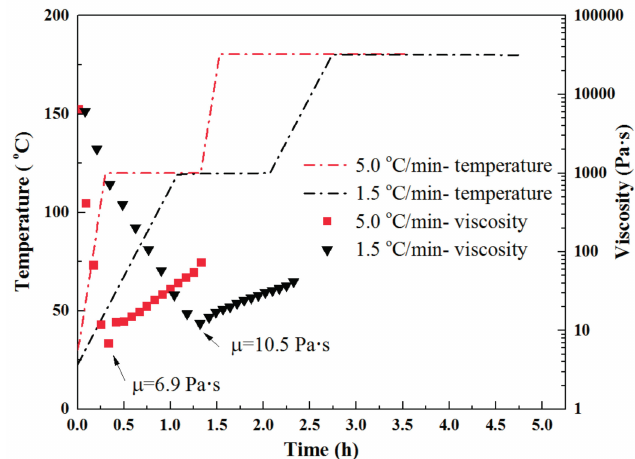
Figure 5. Viscosity evolution during the cure cycle for fast and slow heating